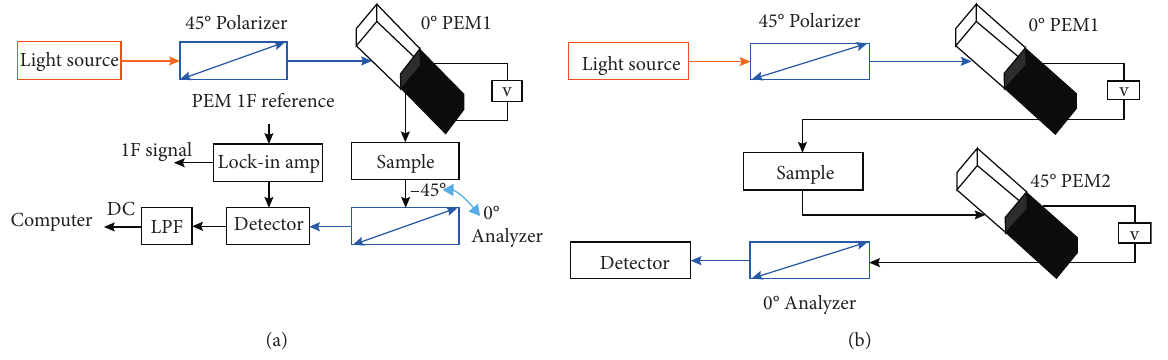
Figure 6: PEM birefringence measurement system. (a) Single PEM. (b) Double PEMs.